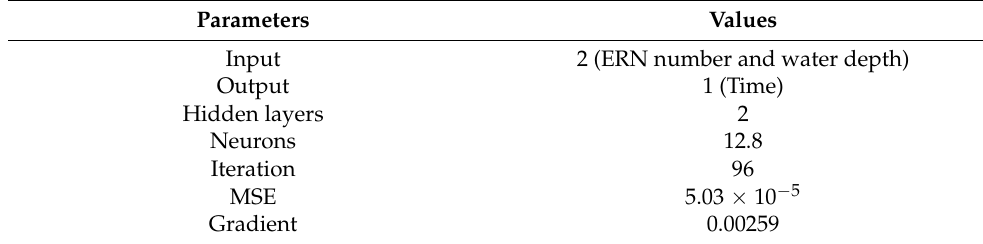
Table 6. Parameters of the trained ANN for the time taken to set up the DP. Parameters Values